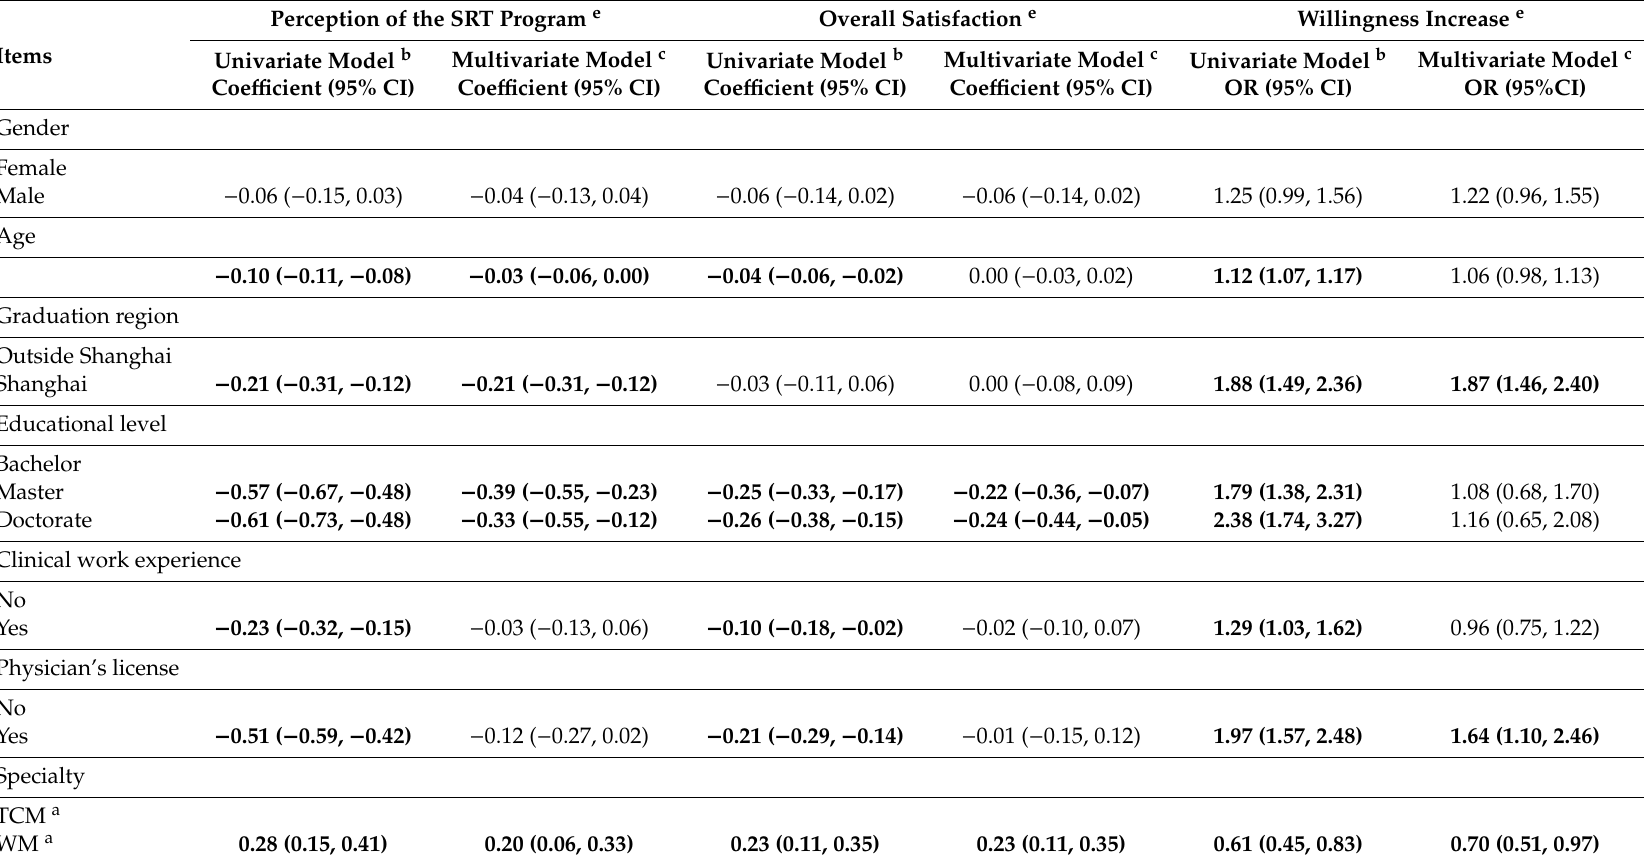
Table 4. Potential factors associated with trainees’ perception of, overall satisfaction toward the SRT program, and change in willingness to become a doctor after the exposure to SRT program ( N = 2114) d